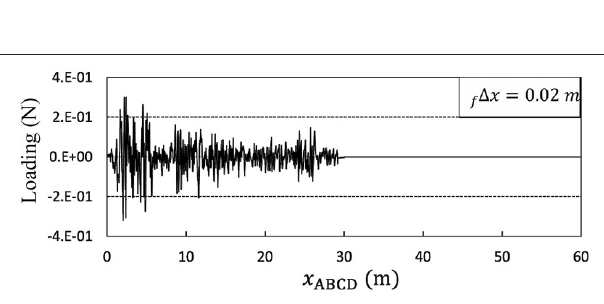
FIGURE 13 | A replacement for Figure 10B for further study on the